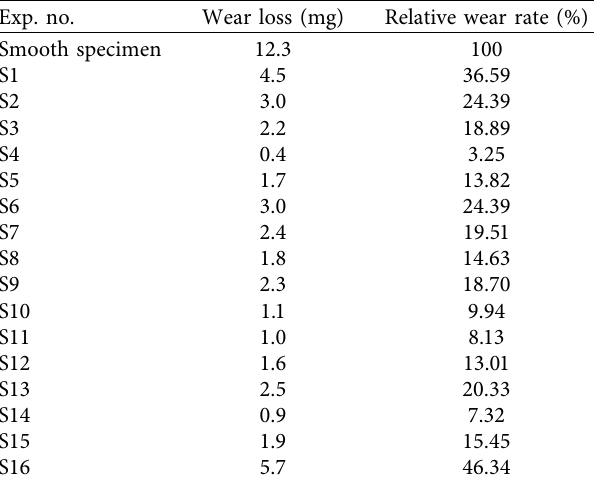
Table 3: Wear test results of friction test specimens. Exp. no.